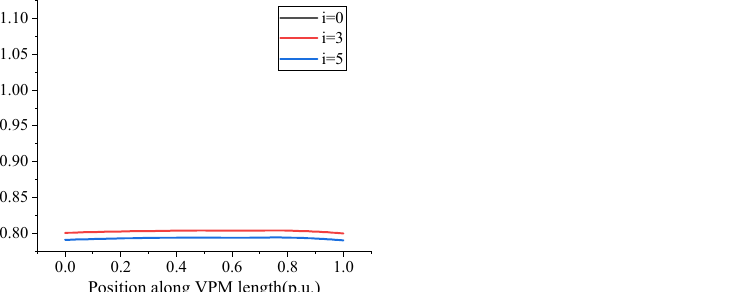
Figure 19. Flux density of VPM under different excitation currents when the permanent magnets are reverse parallel.